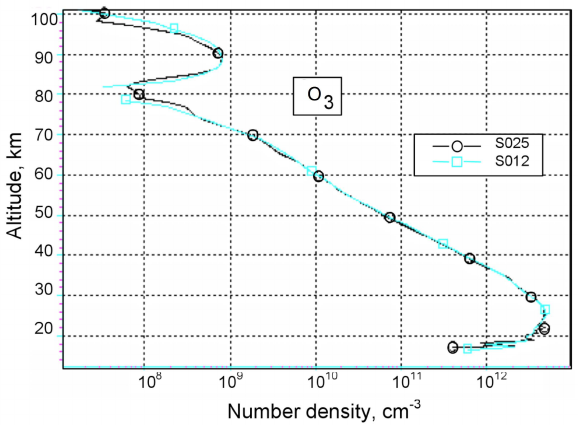
Fig. 23a. Two vertical profiles of ozone obtained at the same geographical location, but on two successive orbits and using two different stars with the tangent points differing by only